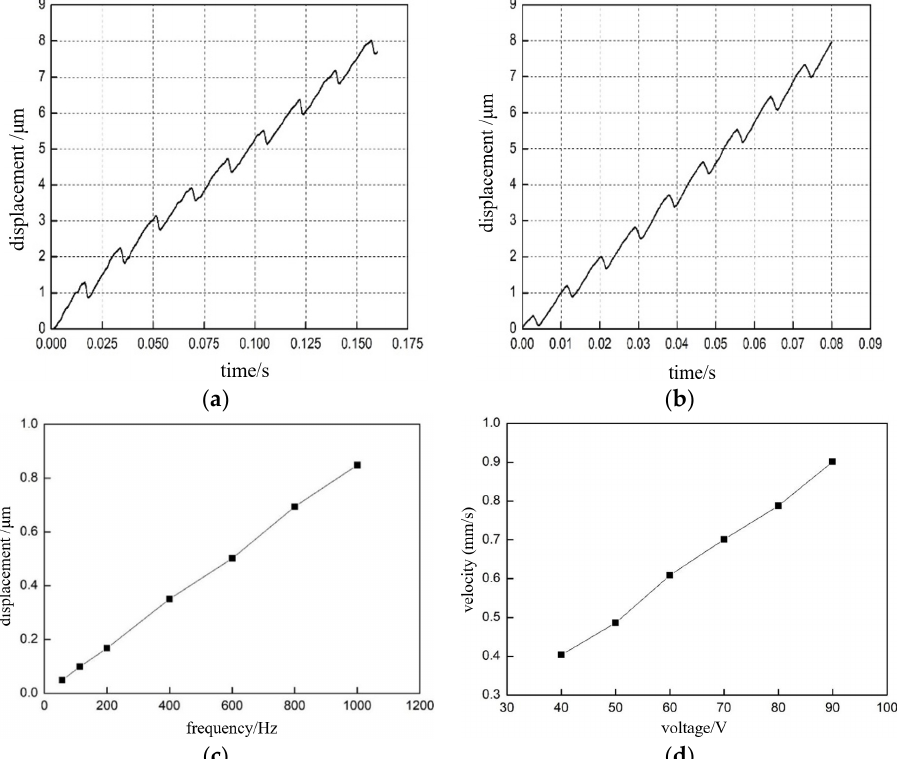
Figure 14. Experimental results of the effect of different input parameters on the motion state of the “macro-motion “: ( a ) positioning stage displacement output curve when the driving frequency is 50 Hz; ( b ) positioning stage displacement output curve when the driving frequency is 100 Hz; ( c ) stage average displacement output curve, driven by multiple drive frequencies; and ( d ) average stage displacement output curve driven by multiple drive voltages.